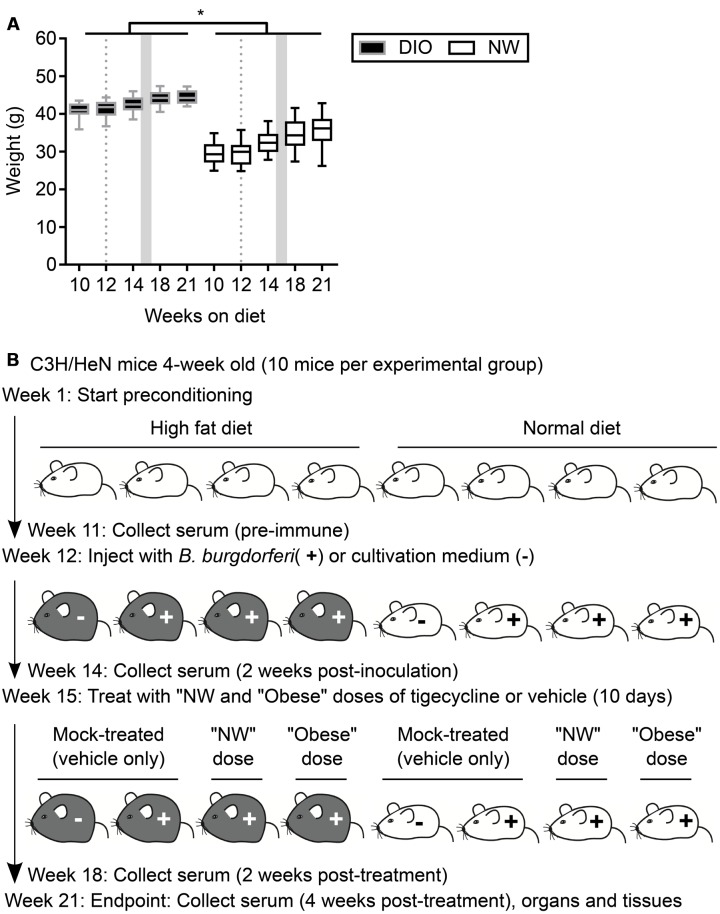
Mouse model of antibiotic treatment of B. burgdorferi infection. (A) Weights of mice were measured throughout the course of the experiment. DIO mice are shown in black (gray margins) and NW mice in white. Box and whiskers represent means with 95% confidence intervals (CI). Gray dotted lines and shaded areas represent the time of infection and the period of antibiotic treatment, respectively. ∗indicates p < 0.05 within individual time points (two-way ANOVA with Holm-Sidak post-tests). (B) Experimental scheme. DIO mice are depicted in gray, NW mice in white. “NW” and “obese” doses consisted of 12.5 mg/kg of tigecycline adjusted to the average weight of lean or DIO mice at the beginning of the treatment (32.5 and 42.7 g, respectively. See Material and Methods for details).